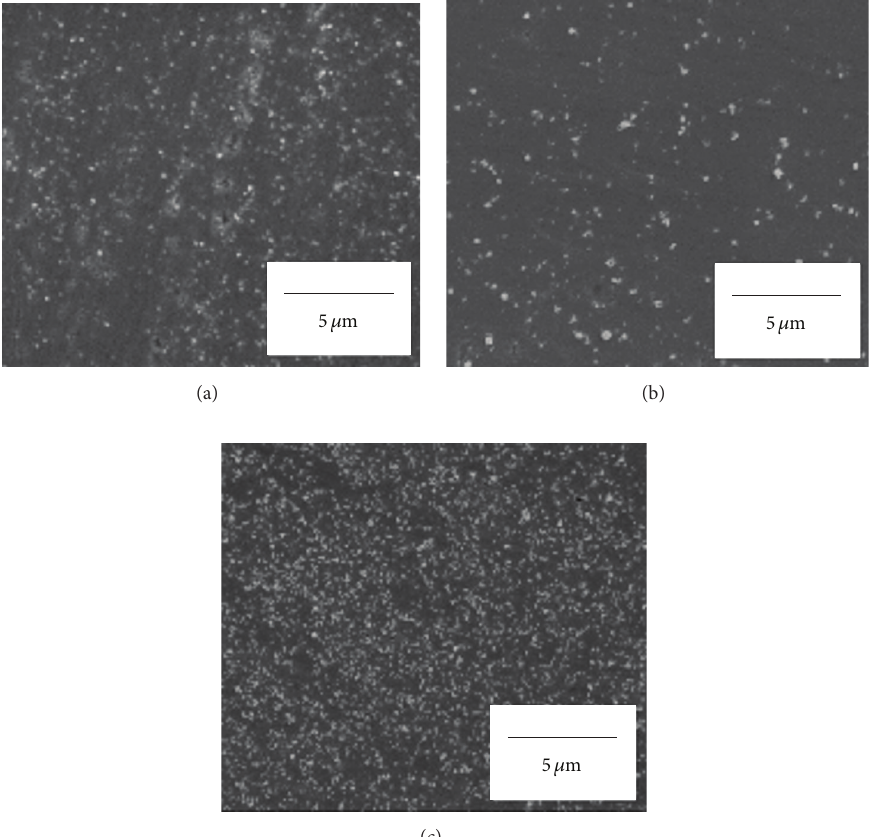
Figure 6: Surface SEM images of the films deposited at various bias voltages (0.5, 2.0, and 5V), with bias frequency of 1 kHz and the Y 2 O 3 concentration of 0.5 wt% in a suspension